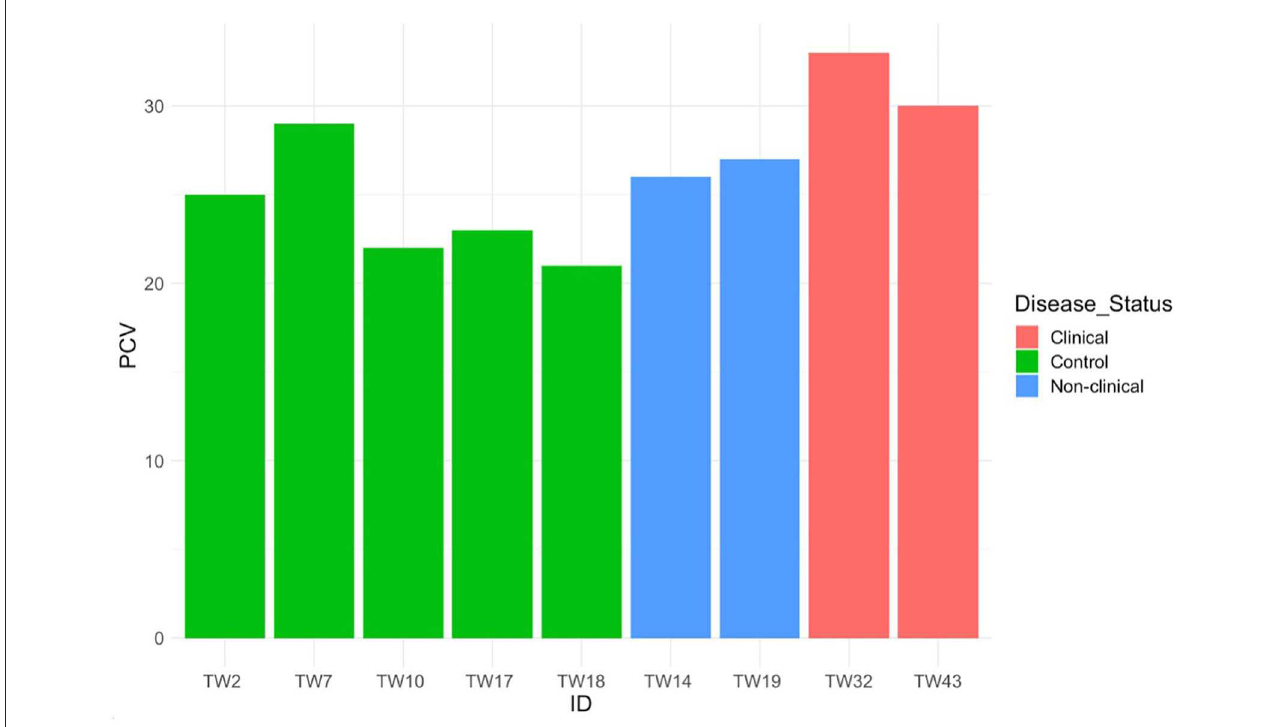
FIGURE9 Packed cell volume for five control, two Batrachochytrium salamandrivorans -exposed/non-clinically diseased, and two Batrachochtyrium salamandrivorans - exposed/clinically diseased Taricha granulosa .